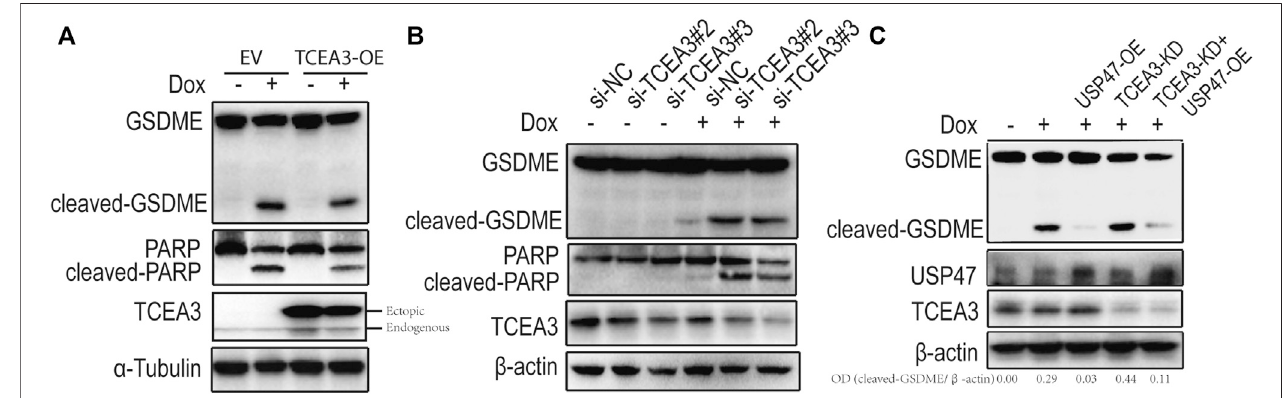
FIGURE 5 | TCEA3 mediated USP47-induced enhancement of pyroptosis and apoptosis. (A) GSDME, PARP and TCEA3 in HCT116 cells over-expressing TCEA3. After transfected with TCEA3-expressing plasmid for 1 day, the HCT116 cells were treated with 1 μ M of Dox for 24 h and examined by immunoblotting. (B) GSDME,PARPandTCEA3inHCT116cellswithTCEA3knockdown. (C) ExaminationofGSDME,USP47andTCEA3inHCT116cellstreansfectedwithsiRNAtargeting TCEA3 and plasmid expressing USP47. TCEA3-OE, TCEA3-overexpressing plasmid; USP47-OE, USP47-overexpressing plasmid; TCEA3-KD, siRNA targeting TCEA3 (si-TCEA3#3).